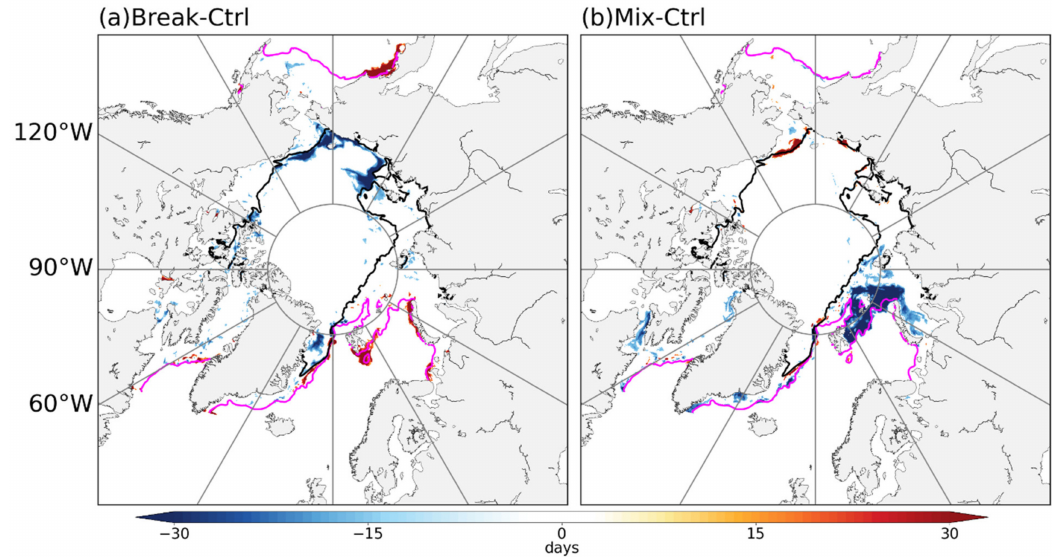
Figure 5. Differences of the length of sea ice season (LSIS) in days between Break and Ctrl ( a ) and between Mix and Ctrl ( b ). Only the differences larger (red) or less (blue) than 15 days are shown in the figure. The magenta line and black line in ( a ) indicate the ice edge (sea ice concentration of 15%) for March and September in the Break experiment, respectively. The magenta line and black line in ( b ) Same as ( a ), but for the Mix